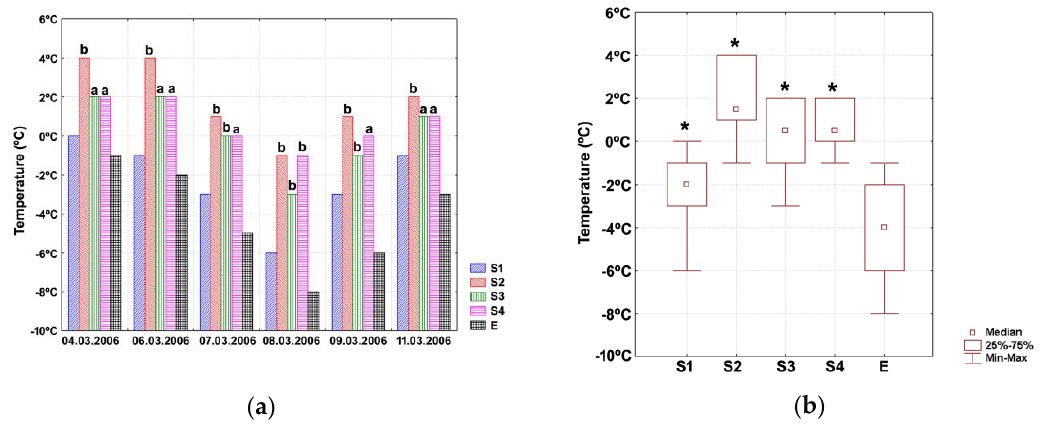
Figure 1. ( a ) Absolute temperature values measured at selected time points for different protective structures. Marked columns ( a,b ) indicate the degree of straw moistening ( a —slight straw moistening, b —moderate straw moistening). S1, soil/LFC; S2, soil/straw/LFC; S3, soil/LFC/straw/HDPE; S4, soil/LFC/straw/10-cm air cushion/HDPE; E, no protection structure (soil). ( b ) Median temperatures for different protective structures. Data are shown as medians (point), with lower and upper quartiles (box) and minimum and maximum values (error bars). Marked boxes (*) indicate significant differences than the reference group (E) (Wilcoxon tests, ***— p ≤ 0.001, **— p ≤ 0.01, *— p ≤ 0.05)..